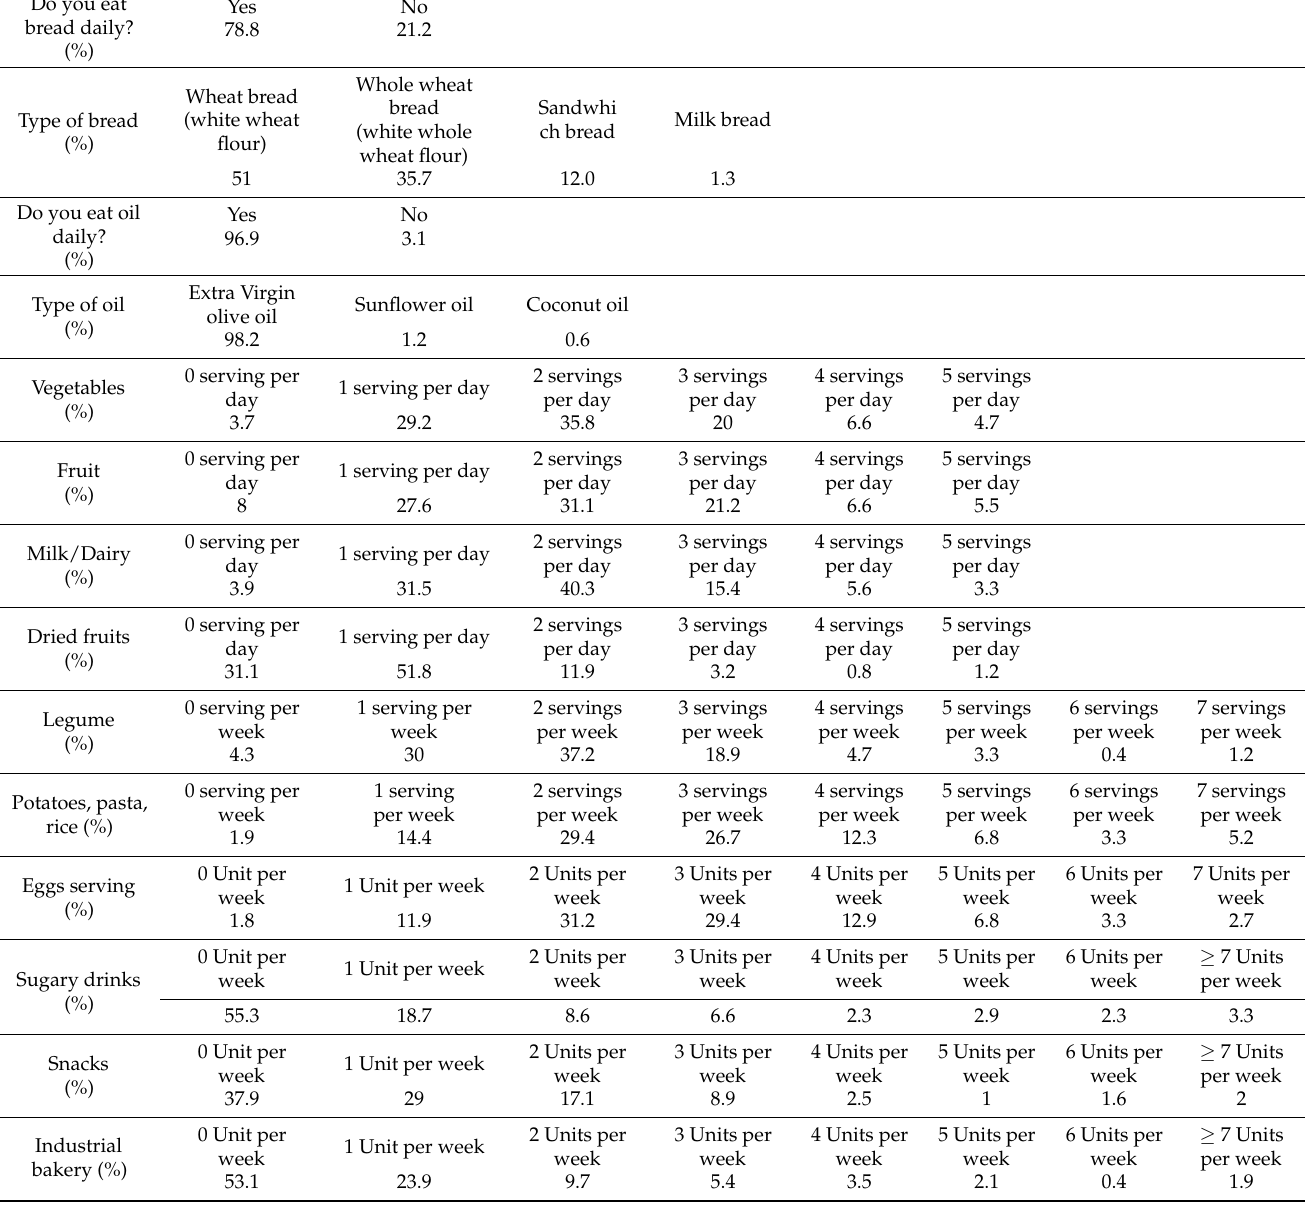
Table 2. Nutritional habits (values are expressed as